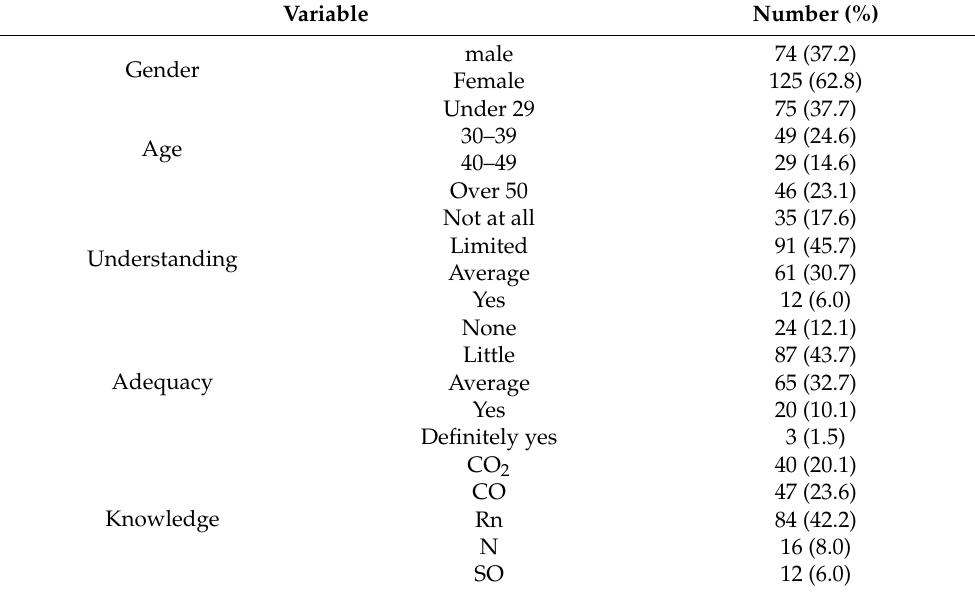
Table 1. Demographics and the levels of comprehension and